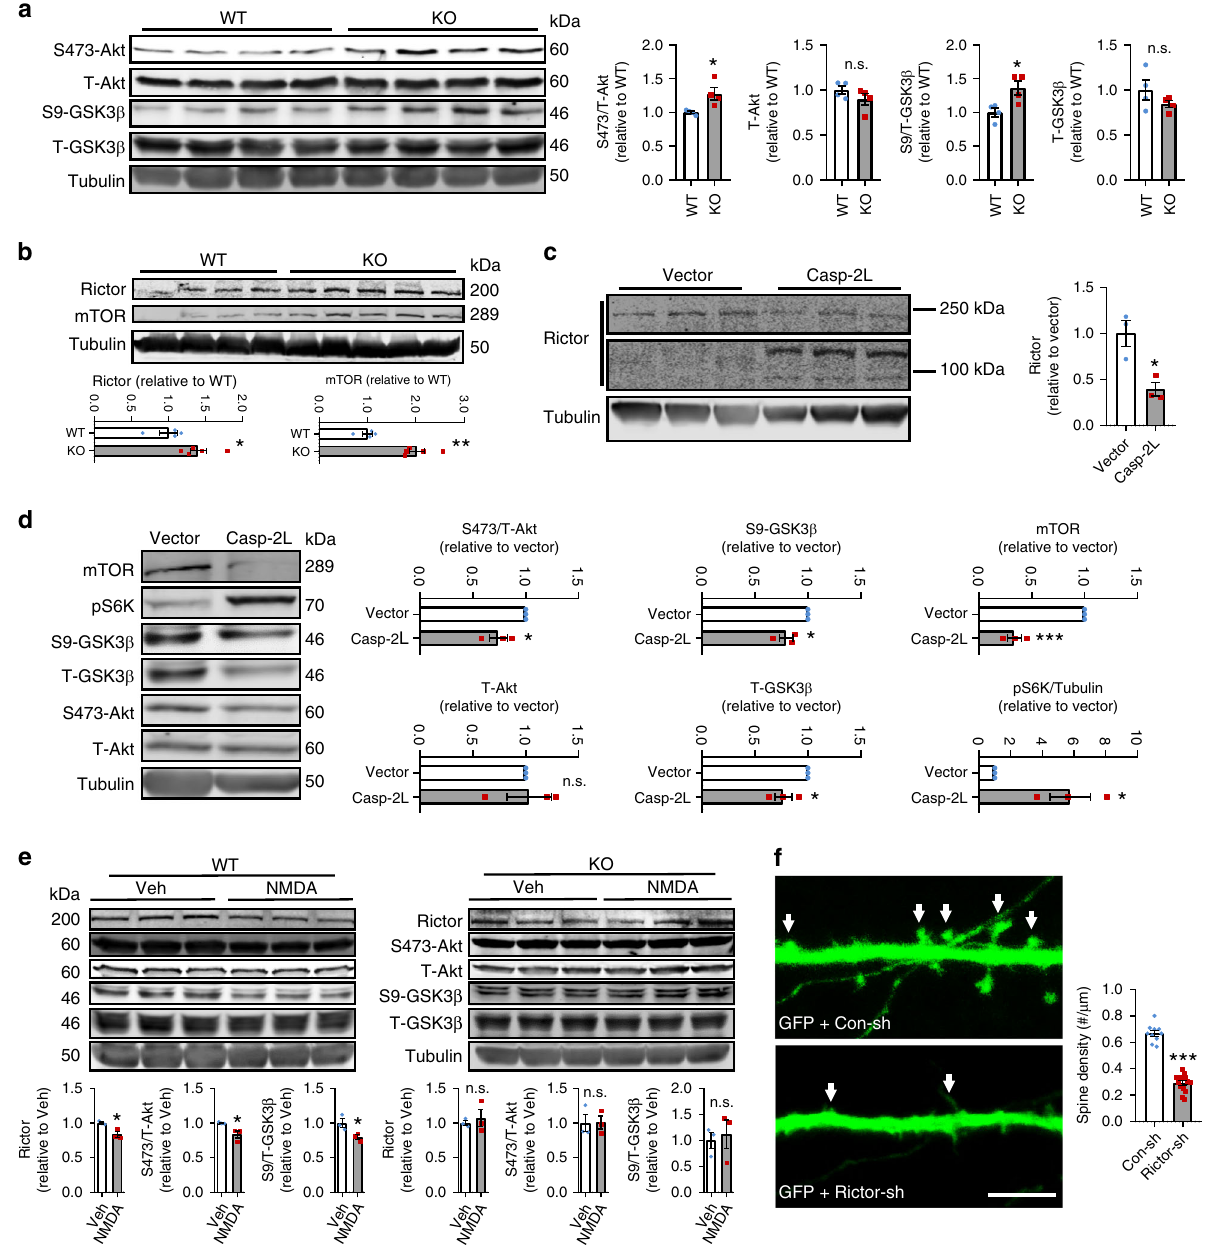
Fig. 5 Caspase-2 regulates the Akt-GSK3 β signaling cascade through cleavage of Rictor. a Immunoblotting analysis and quanti fi cation of total Akt, Ser473- Akt, total GSK3 β , and Ser9-GSK3 β in the hippocampus of WT and Casp2 KO mice. Tubulin was used as a loading control. n = 4 per genotype. b Levels of Rictor and mTOR in the hippocampus of WT and Casp2 KO mice. WT, n = 4; KO, n = 5. c Cleavage of Rictor in cultured mouse hippocampal neurons infected with lentivirus expressing caspase-2L. Note that full-length Rictor is 200 kDa, whereas the two cleavage products are above and below 100 kDa, respectively. d Immunoblotting analysis and quanti fi cation of total Akt, Ser473-Akt, total GSK3 β , Ser9-GSK3 β , mTOR, and pS6K in cultured mouse hippocampal neurons. Neurons on DIV6 were infected with lentivirus expressed GFP or caspase-2L and lysed 96 h later. n = 3 for each viral vector. e Immunoblotting analysis and quanti fi cation of Rictor, total Akt, Ser473-Akt, total GSK3 β , and Ser9-GSK3 β in cultured WT and Casp2 KO mouse hippocampal neurons treated with vehicle or NMDA. n = 3. f Knockdown of Rictor with shRNA (Rictor-sh) reduced spine density in cultured hippocampal neurons compared with control shRNA (Con-sh). Con-sh, n = 10 neurons; Rictor-sh, n = 14 neurons; Scale bar, 5 μ m. Data are presented as mean ± SEM. Two-tailed Student ’ s t test: n.s. for p > 0.05, * p < 0.05, ** p < 0.01, and *** p < 0.001. Source data are provided as a Source Data fi